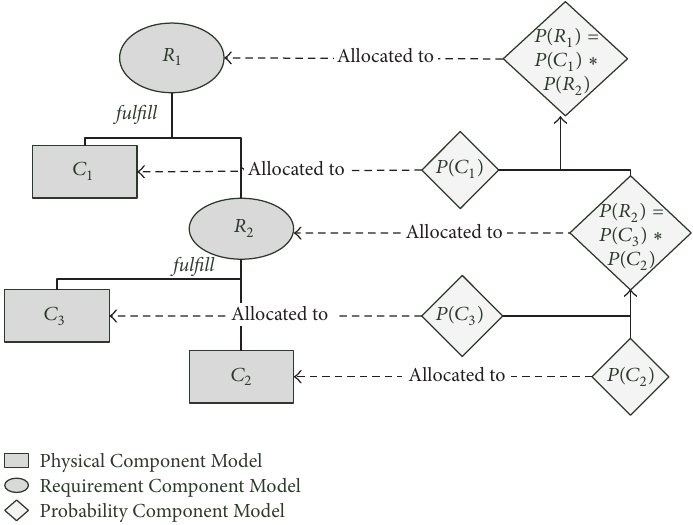
Figure 2: Probability Model integration in a Modelica-based design.